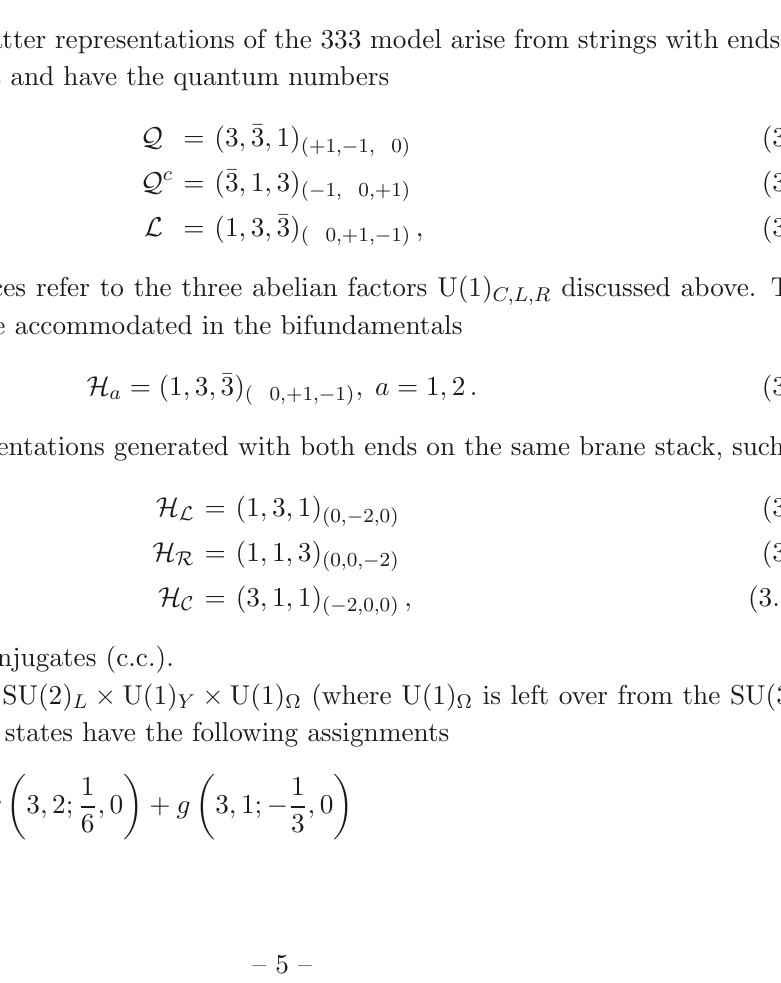
Figure 1 . Intersecting D-brane stacks for the trinification model. Also shown are strings attached to D-branes whose excitations give rise to the representations explained in the